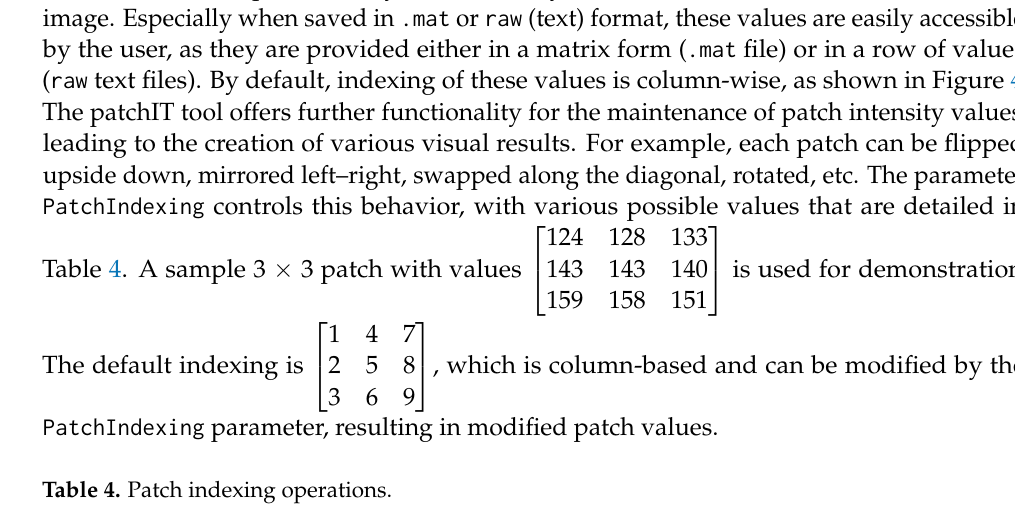
Figure 7. Applying a mask in random mode: ( a ) the source image; ( b ) a probability mask and 15 non-overlapping patches located in high-probability areas; ( c ) the resulting extracted patches.